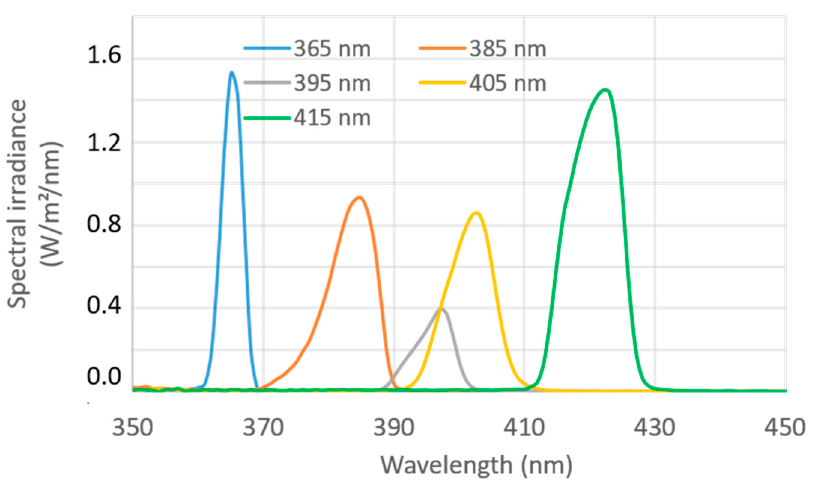
Figure 7. Emission spectra of LEDs used for autofluorescence excitation on the SpectroLive device measured using the Specbos 1211 (Jeti ® ) spectroradiometer.